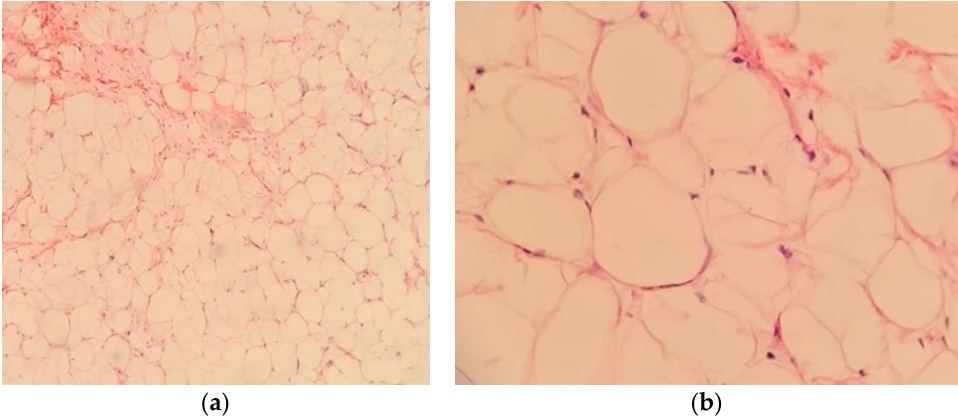
Figure 1. Adipose tissue stained with hematoxylin and eosin (H&E); ( a ) original magnification ×10, adipose hyperplasia tissue with thickened fibrous septae and increased vascular network. ( b ) original magnification ×40, adipose tissue demonstrating enlarged (hypertrophic) adipocytes. Prepared by the authors. Courtesy of the Pediatric Clinical Hospital Sibiu, Lucian Blaga University of Sibiu.